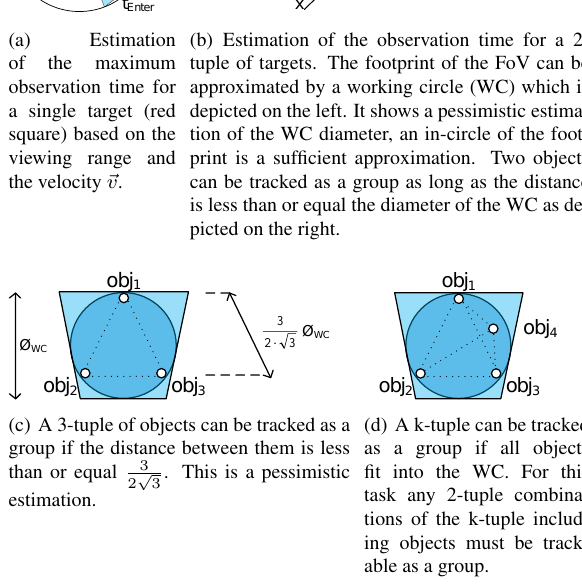
Figure 9: Calculation of k-tuple of trackable objects.